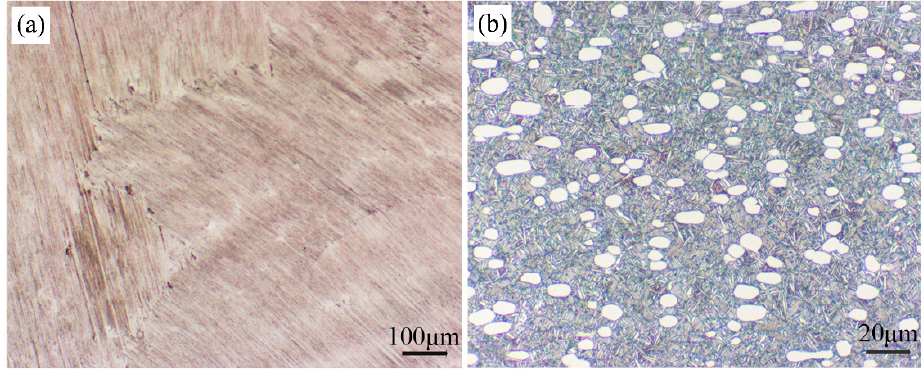
Figure 1. Optical micrographs showing the original microstructure of the ( a ) Ti-46Al-2Cr-5Nb and ( b ) Ti-24Al-15Nb-1.5Mo alloys .